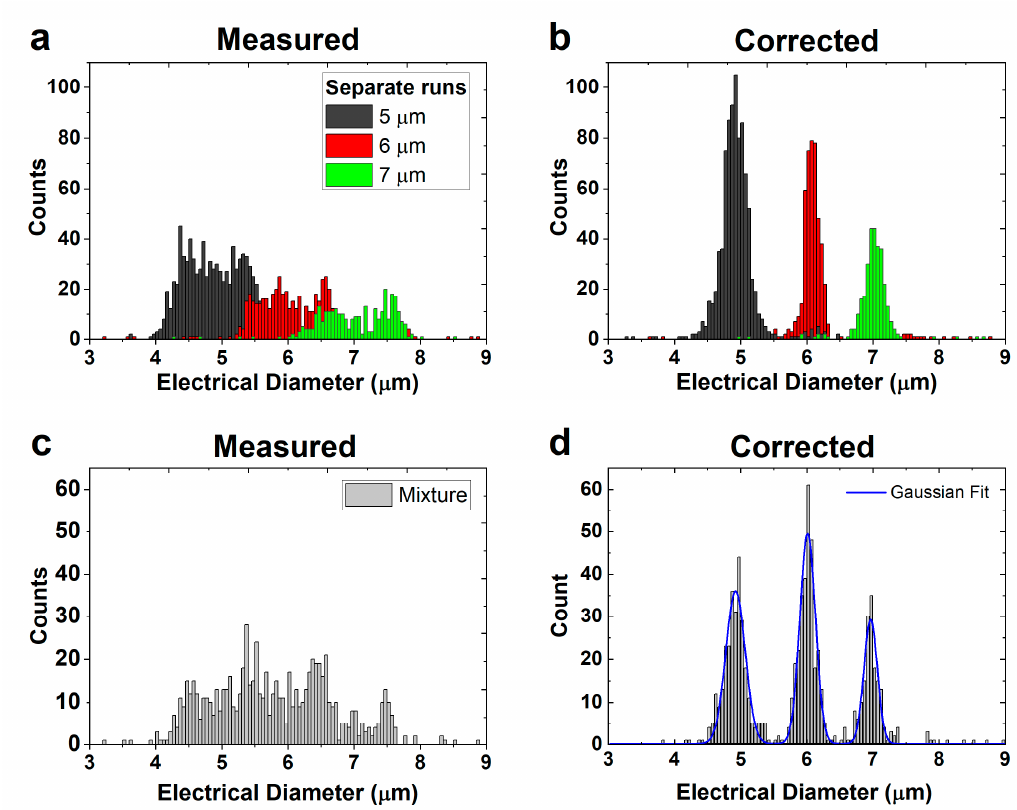
Figure 5. ( a ) Spread in electrical diameter of three separate runs of 5, 6, and 7 µ m beads. ( b ) The corrected electrical diameter of the beads in ( a ). ( c ) Spread in electrical diameter of a mixture of 5, 6, and 7 µ m beads. ( d ) The corrected electrical diameter of the mixture of beads with a Gaussian fit.